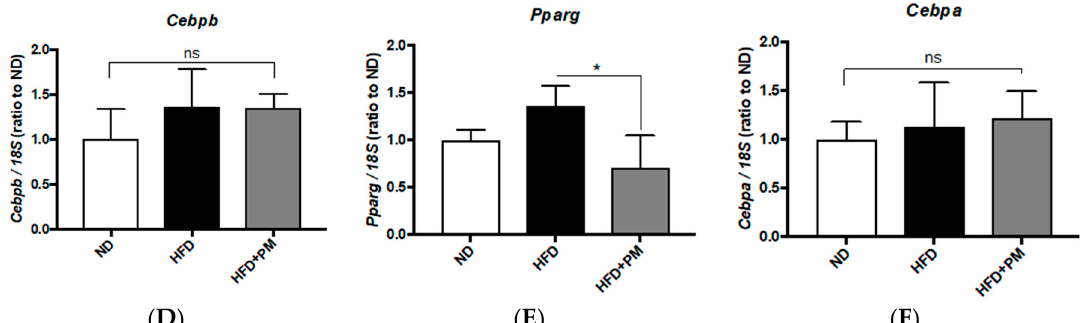
Figure 6. PM-induced gene expression changes in VAT of zebrafish and mice. ( A – C ) PM effects on gene expression related to adipocyte differentiation in zebrafish. PM downregulated cebpb ( A ), pparg ( B ) and cebpa ( C ) expression. ( D – F ) PM effects on gene expression related to adipocyte differentiation in mice. PM did not affect Cebpb ( D ) and Cebpa expression ( F ), while Pparg expression ( E ) was suppressed by PM compared to HF group. * p < 0.05. n = 6, error bars indicate SD.